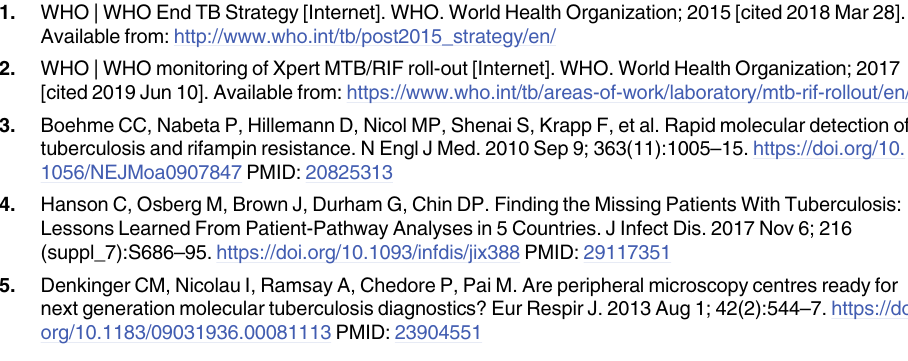
S7 Table. Univariate linear regression analysis of the relationship between CRP and selected variables. All variables with a p value < 0.1 were considered for inclusion into multi- variable analysis. Akaike Information Criterion values were then used to build the best model. CD4 count was excluded from the multivariable model despite meeting significance as only 95 study participants had recorded values. AIC was not reported for CD4 count as sample size dif- fered from other